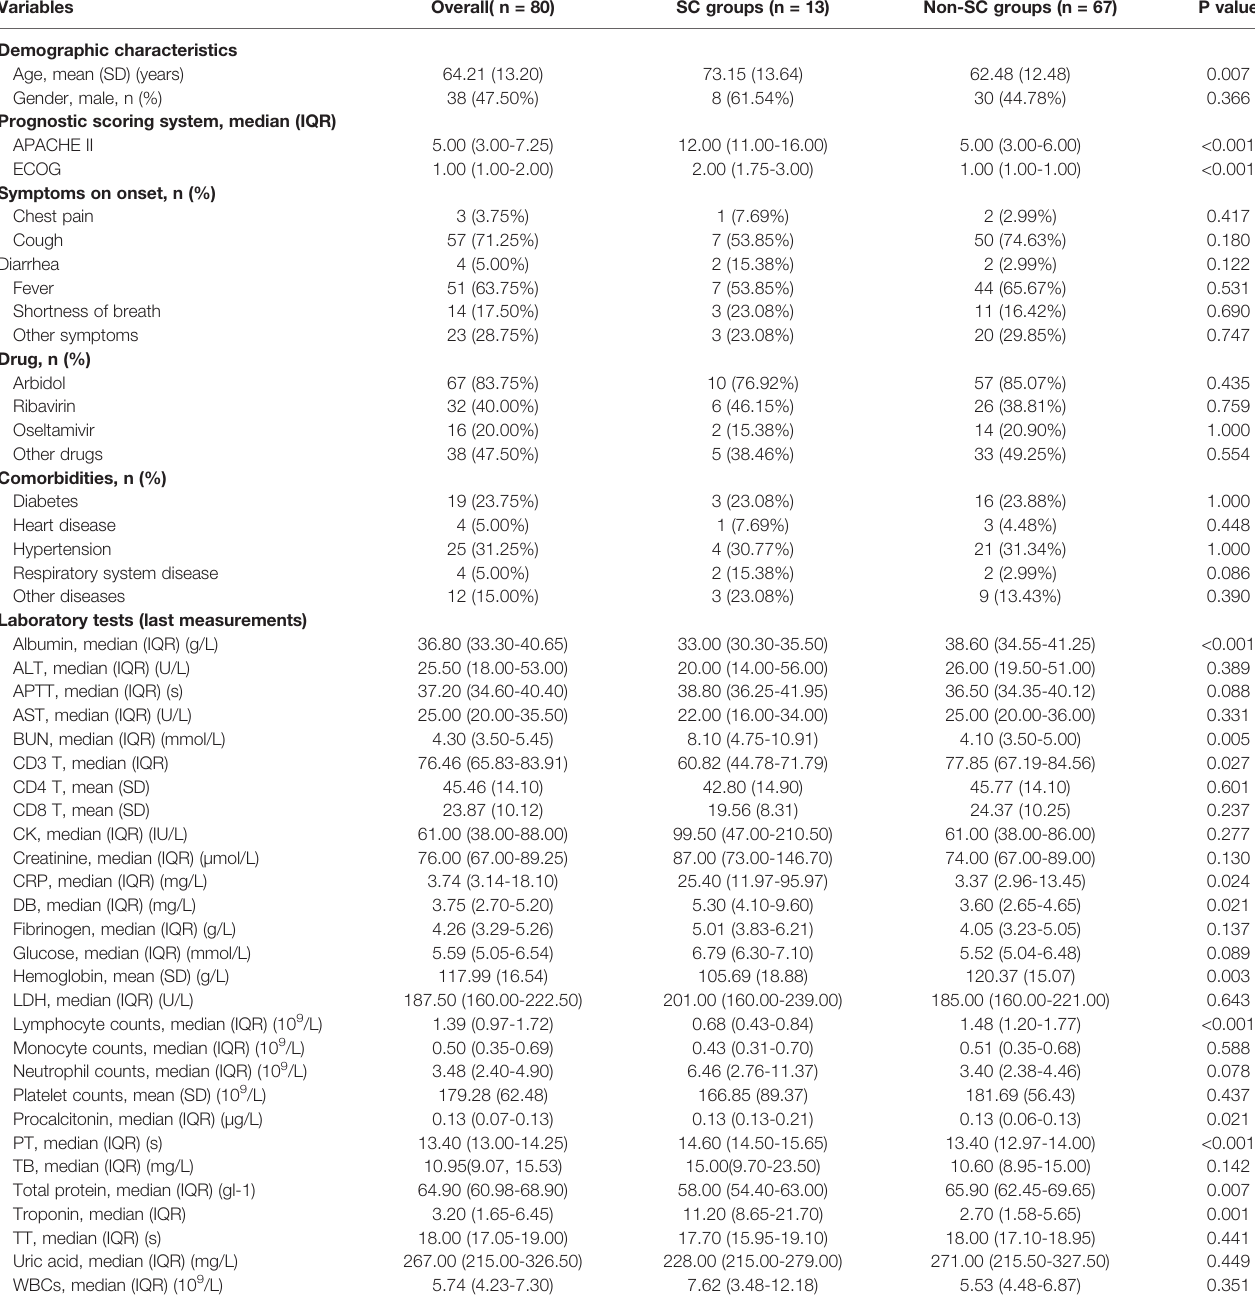
TABLE 2 | Statistics of the clinical variables for COVID-19 data. Variables Overall( n = 80) SC groups (n = 13) Non-SC groups (n = 67) P value Demographic characteristics Age, mean (SD)